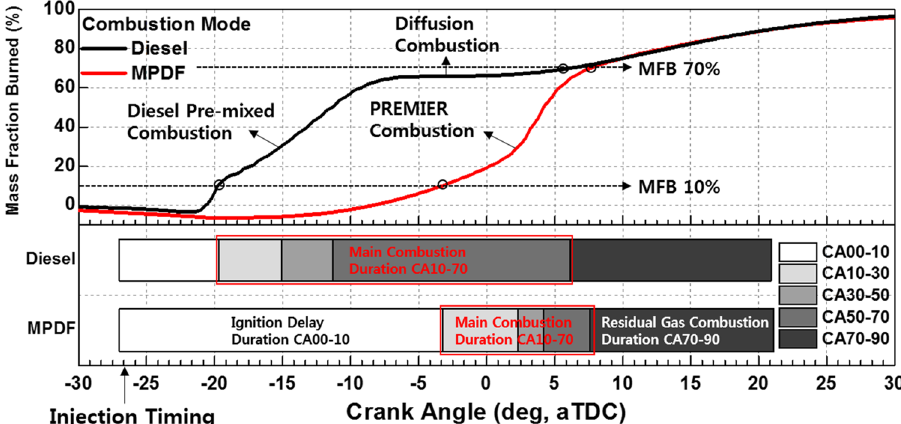
Figure 6. MFB for diesel and MPDF combustion.